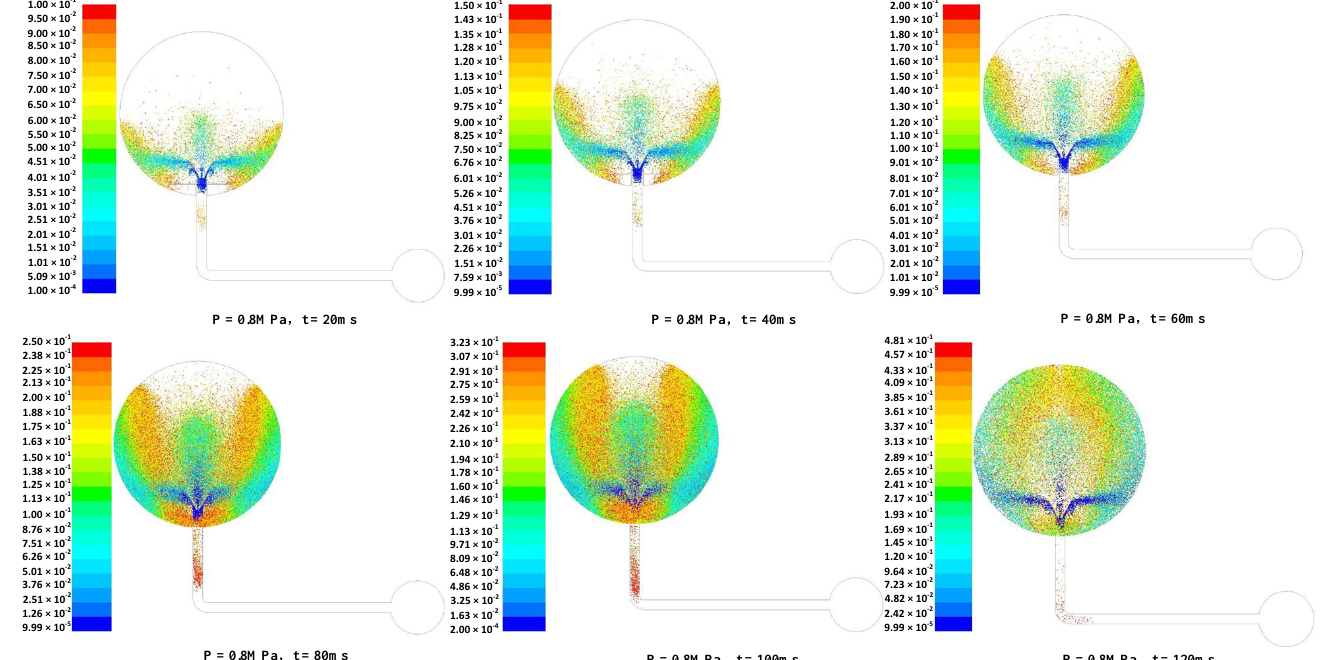
Figure 8. Aerosol velocity–time contour maps at different time points (20 ms, 40 ms, 60 ms, 80 ms, 100 ms, 120 ms) at a powder injection pressure of 0.8 MPa. 100 ms, 120 ms) at a powder injection pressure of 0.8